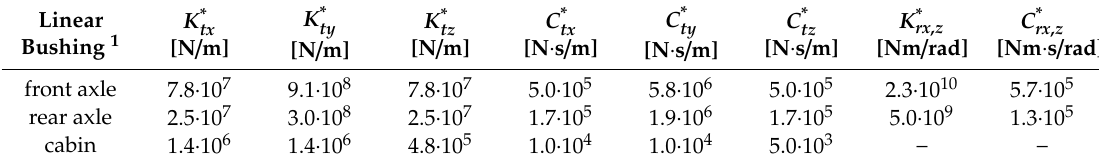
Table 3. Linear bushing parameters of the Traigo 80 rigid-body model after updating. Linear Bushing 1